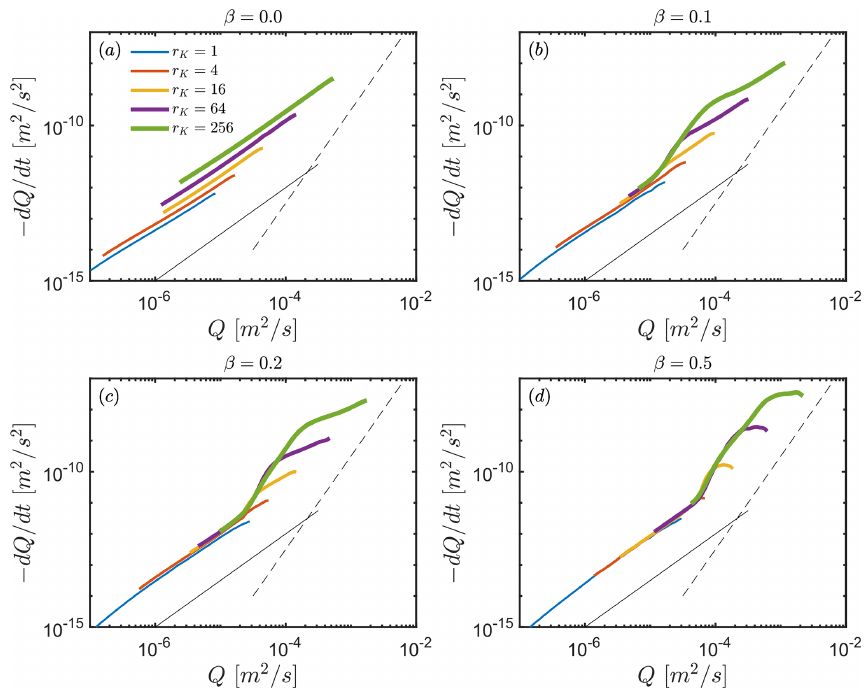
Figure 4. Recession plots displaying − d Q/ d t vs. Q in a log–log space obtained for different hydraulic conductivity ratios r K and different slope angles of the interface between shallow and deep compartments β . D is fixed at 20m and α at 100m. Lines of b = 3 and b = 15 are drawn for reference.